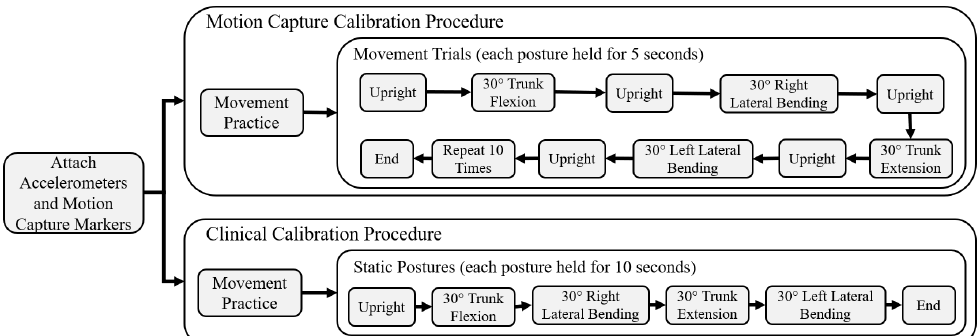
Figure 3. Experimental procedure flowchart for both the motion caption and clinical calibration methods.